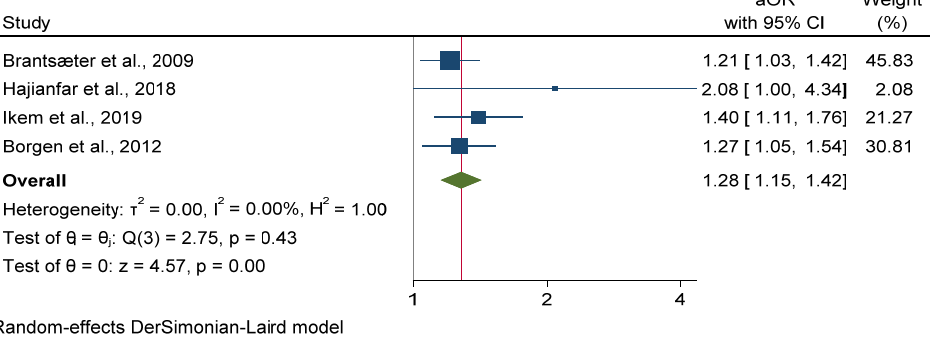
Figure 4. Meta-analysis of ultra-processed food rich diet vs. preeclampsia.